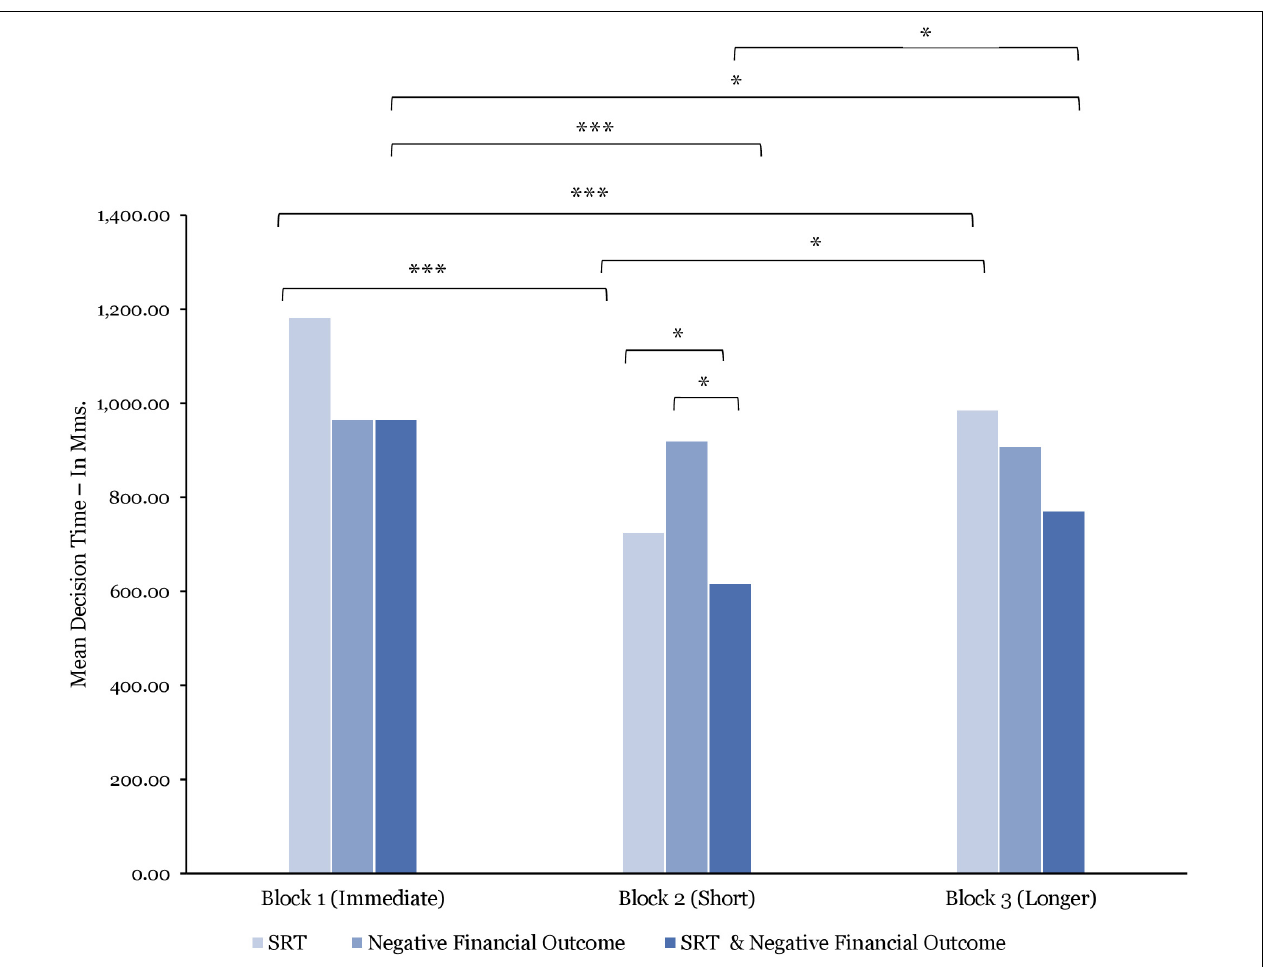
FIGURE 10 | Comparisons of mean decision time by stress manipulations and by blocks. Significant differences are marked as ∗ p < 0.05; ∗∗∗ p < 0.001.